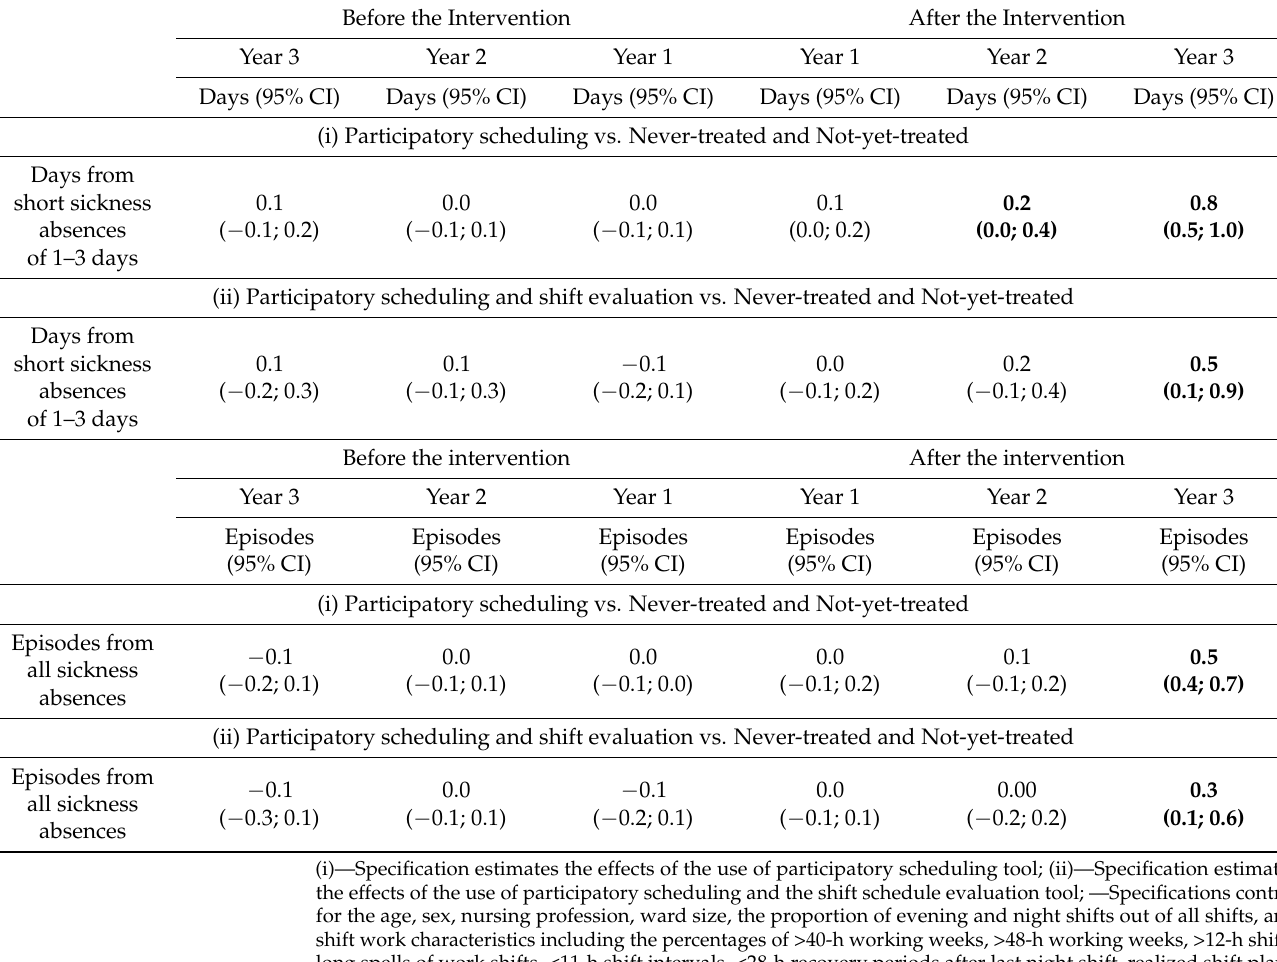
Table 3. The estimated effects of the use of the participatory scheduling tool and the shift schedule evaluation tool on sickness absence days from short absences of 1–3 days and episodes from all absences. Event study estimates with ward-level clustered standard errors. Statistically significant differences are bolded. The Difference in Outcome Measures Before the Intervention After the